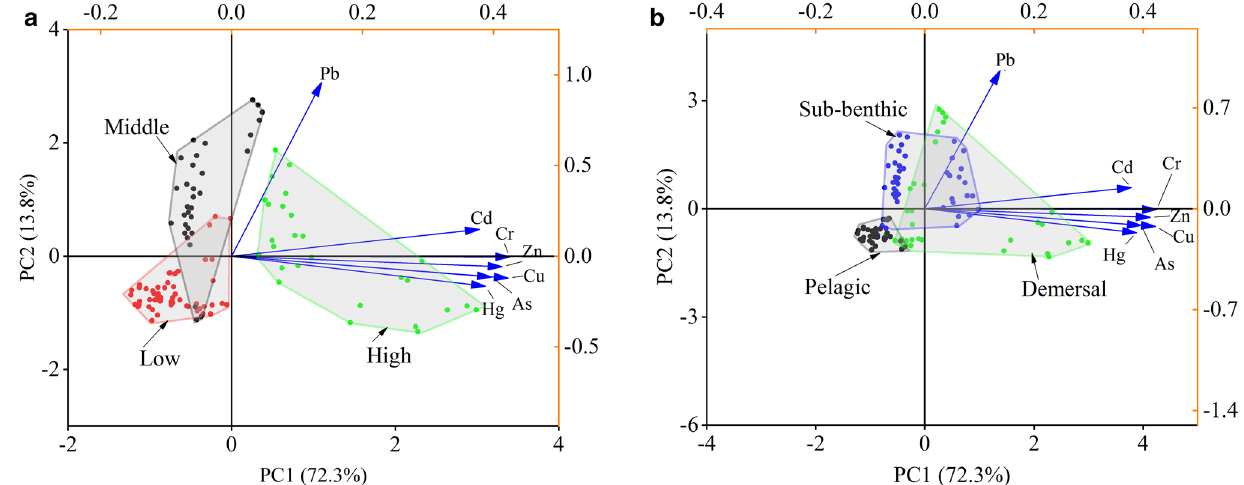
Figure 2. Principal component analysis (PCA) of trace metal contents in the fish with different trophic guilds ( a ) and different habitat preferences ( b ) from Xincun Lagoon, South China Sea.